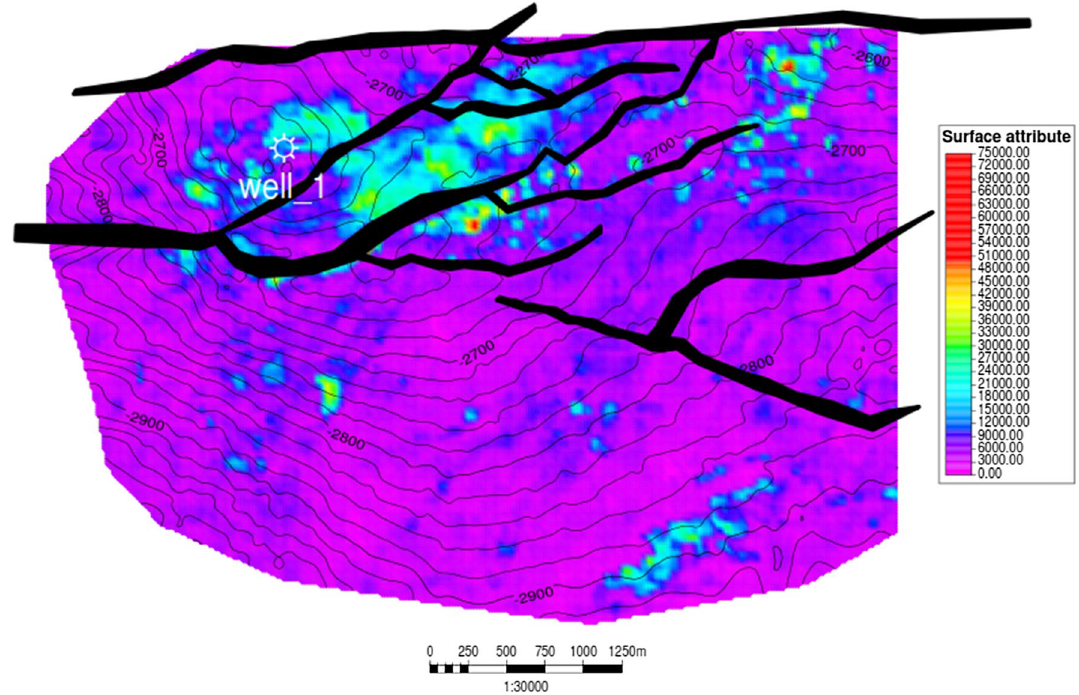
Fig. 4 Well-1 amplitudes, superimposed on two-way time structure